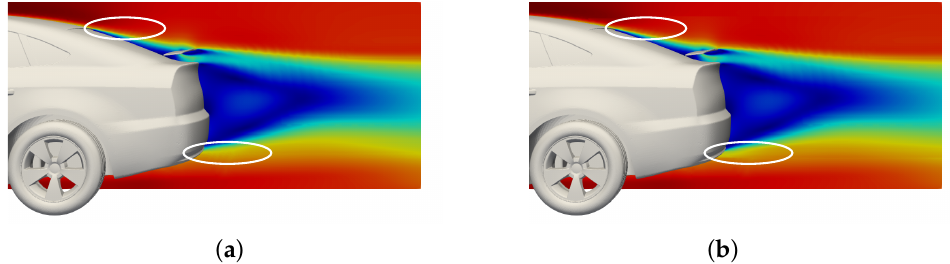
Figure 15. Influence of oPOD interpolation region. ( a ) oPOD prediction with interpolation. ( b ) oPOD prediction without interpolation.